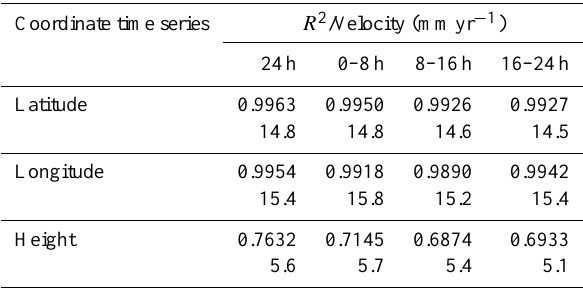
Table 1. Comparison of the R 2 values and deformation rates for all three GPS baselines from the station KIRU. R 2 values are obtained through the regression analysis of GPS solution time